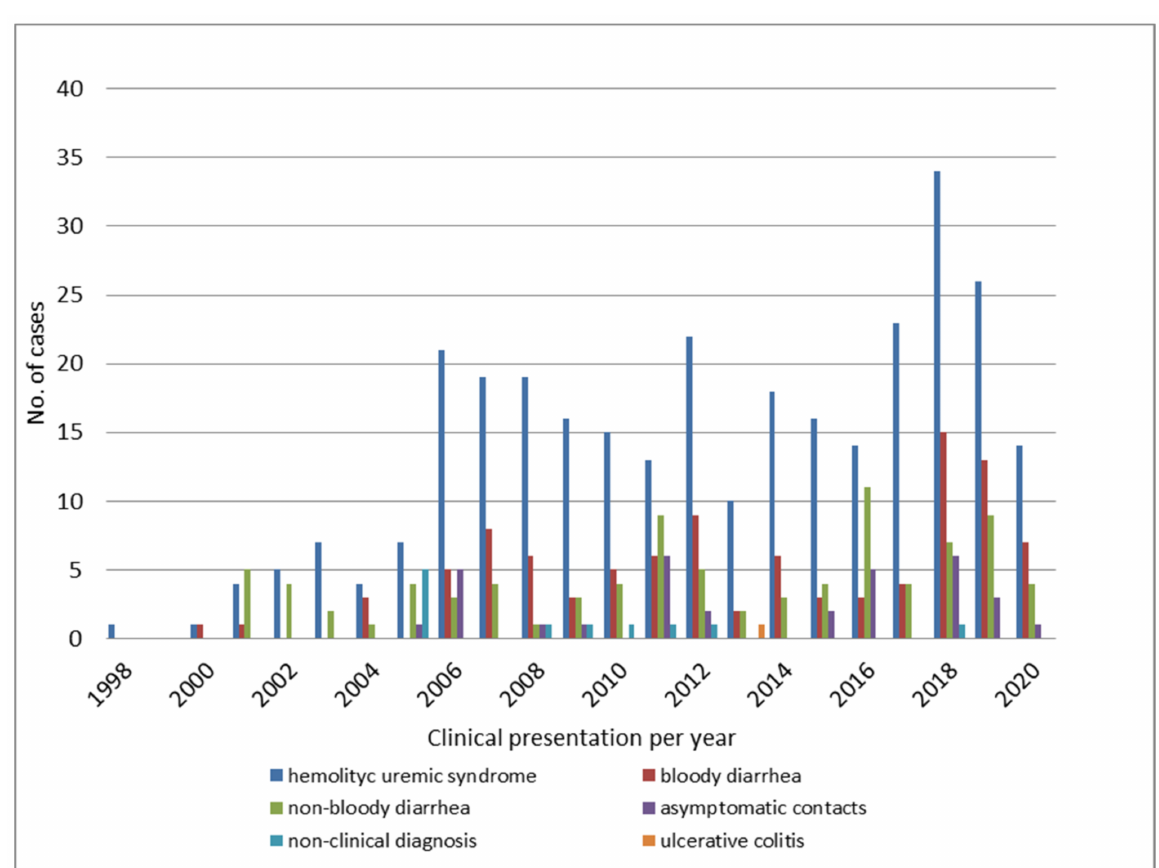
Figure 2. Clinical presentation of STEC O145 infections throughout the